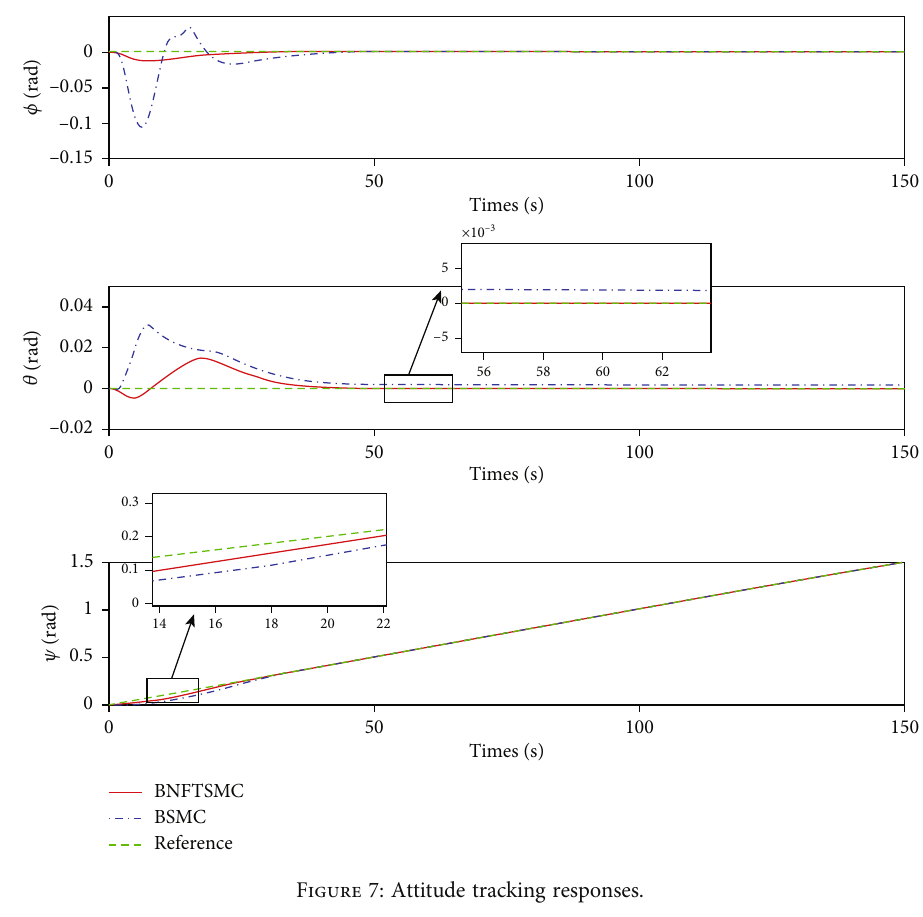
Figure 7: Attitude tracking